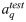
Color matching is a projection.Blue and green curves are as in Fig 10 and correspond to aqtest and aqcomp[cmatch]. After regression, the green one should be the nearest to the blue one with respect to the L∞ norm, among all the curves {aqcomp[c]}c generated by the family of comparison images {Jcomp[c]}c∈Copp (shown in gray).